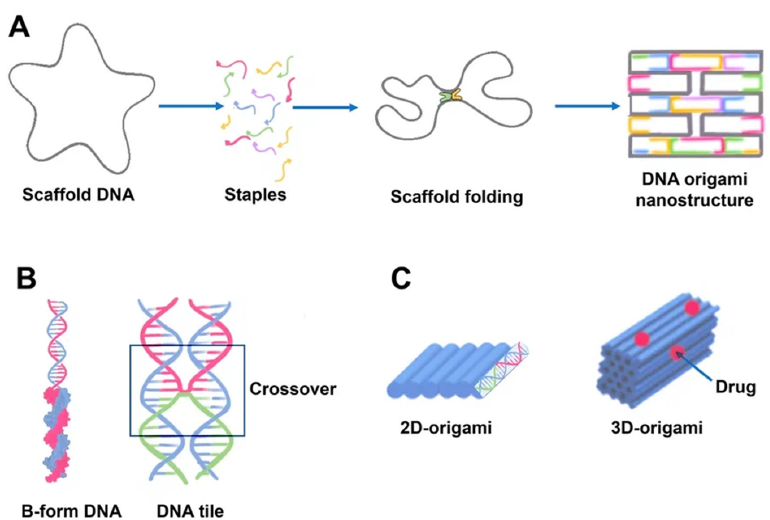
Figure 2. Schematics of DNA origami assembly and its structural features. ( A ) DNA origami assembly from the directed folding of the scaffold strand (gray) by using complementary staple strands (multicolored). Scaffold DNA functions as a guide or seed in the folding process, increasing folding efficiency and strand stoichiometry robustness. Each staple, for example, the blue strand, is incorporated specifically based on its sequence. The staples can connect distant sections of the scaffold by base pairing resulting in formation of a predefined form. The helices are formed by a scaffold chain (black) and a number of staple chains (colored). The lattice geometry is the consequence of crossings between the helix and its neighbors occurring seven base pairs apart. ( B ) The geometry of DNA crossovers in DNA helices for the creation of 2D origami designs. Every staple oligonucleotide binds to various regions of the scaffold DNA, producing double-helical tracts and connecting them. Individual interhelically connected tracts form a dense lattice in space. The connections, or crossovers, resemble an antiparallel Holliday four-way junction. Individual helical domains are connected by interhelix crossovers (in frame). Helices are linked to one another at regular intervals by junctions where scaffold or staples cross from one helix to the next. ( C ) 2D and 3D origami. DNA origami may be used to generate higher-order structures as a unit tile. A linear arrangement of DNA helices may be used to create 2D DNA origami. Cylinders are double-stranded DNA strands generated by base pairing of the DNA strands. 3D origami can be made by stacking multiple DNA helices on various